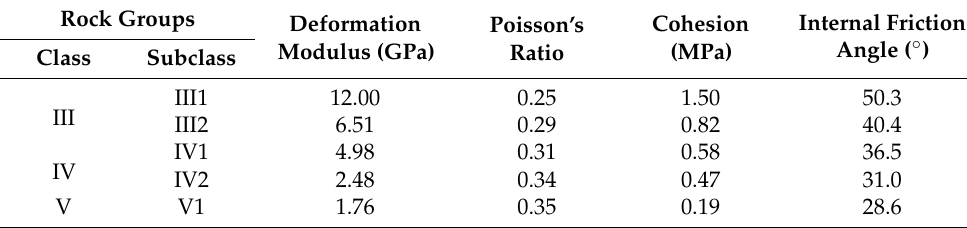
Table 2. Back analysis results of rock parameters for stage I of water impoundment.